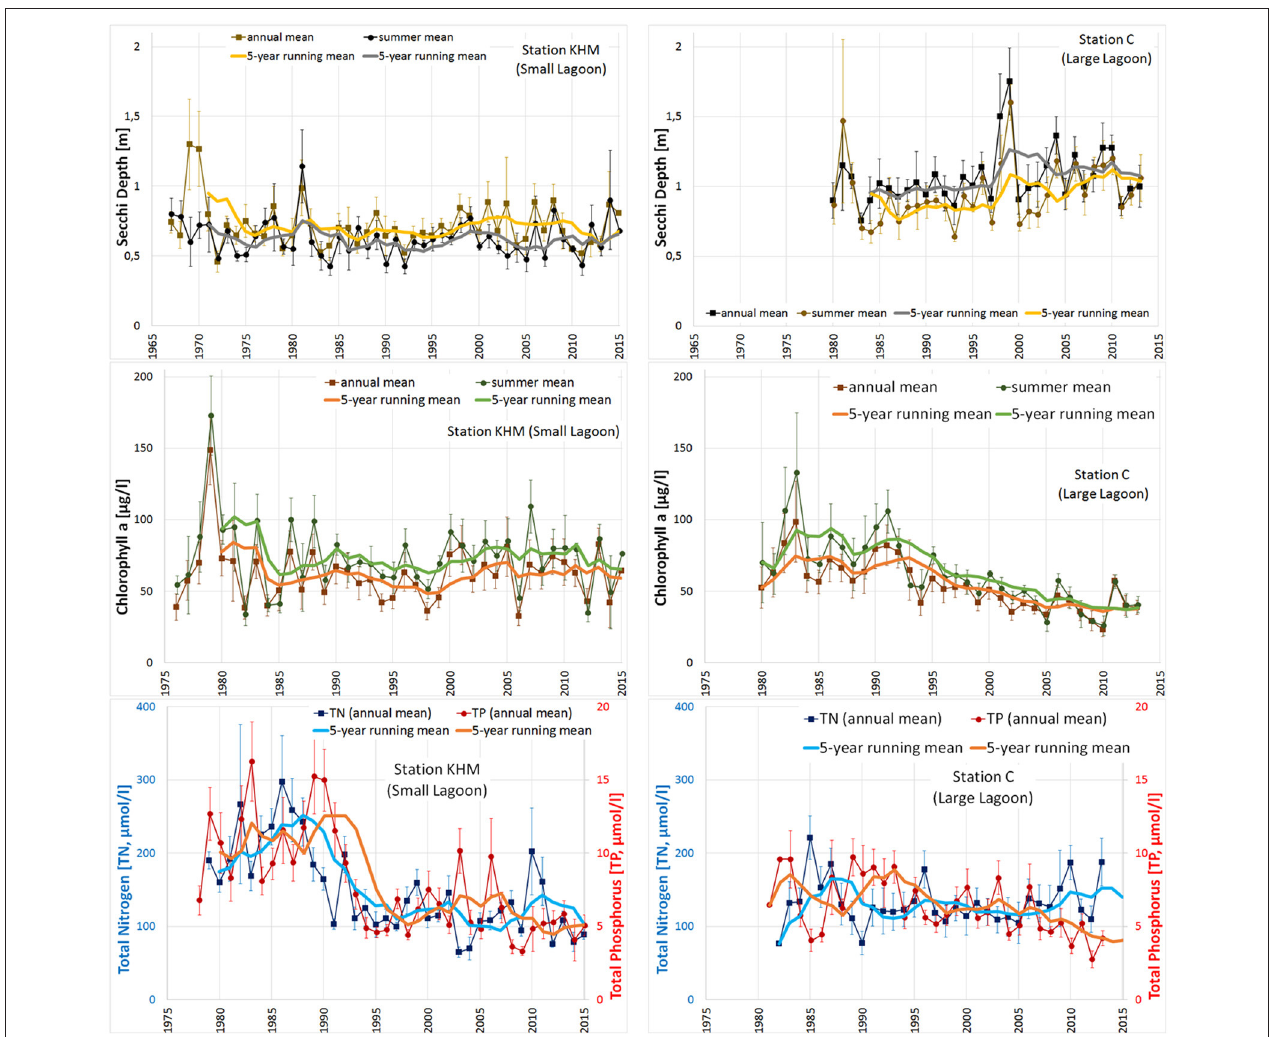
FIGURE 4 | Long-term time series of water quality parameters Secchi depth (m, upper panel), chlorophyll-a ( µ g/l, middle) and TN & TP concentrations ( µ mol/l, lower panel) together with standard errors and 5-year running means at the central stations of Small Lagoon (KHM, left column) and Large Lagoon (station C, right column). Summer period refers to